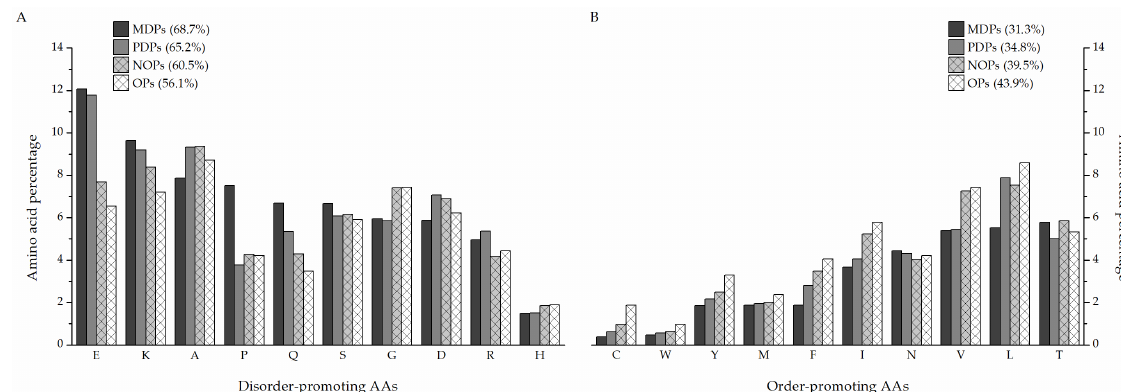
Figure 6. Ratios of individual disorder ( A ) and order-promoting amino acids ( B ) in mostly disordered (MDPs), partially disordered (PDPs), nearly ordered (NOPs), and ordered proteins (OPs), ordered by abundance in